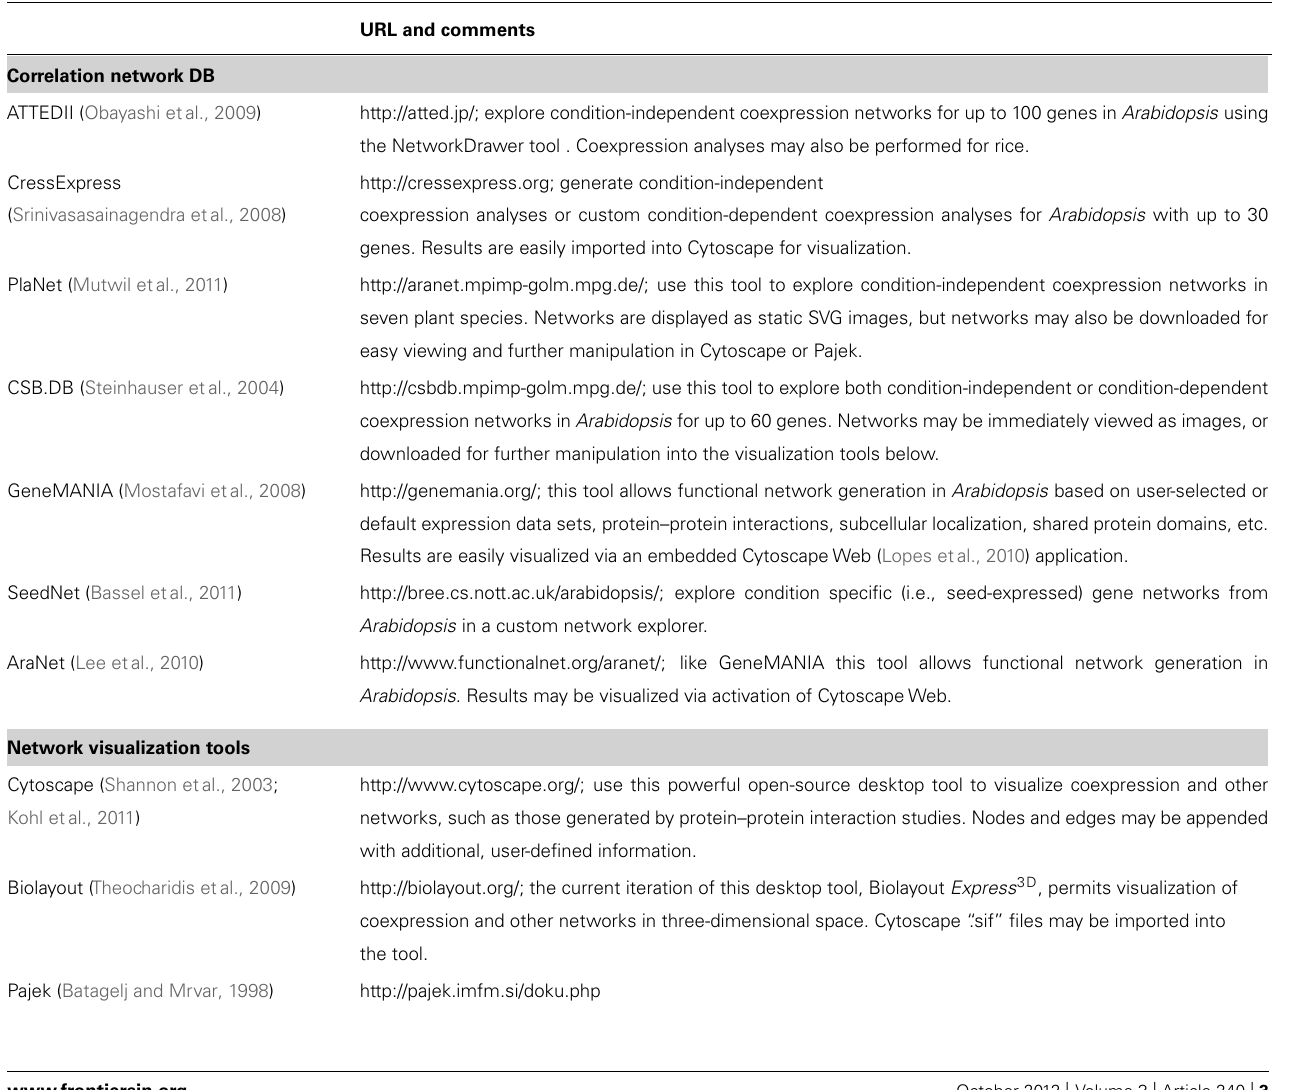
Table 1 | Selected correlation network databases and